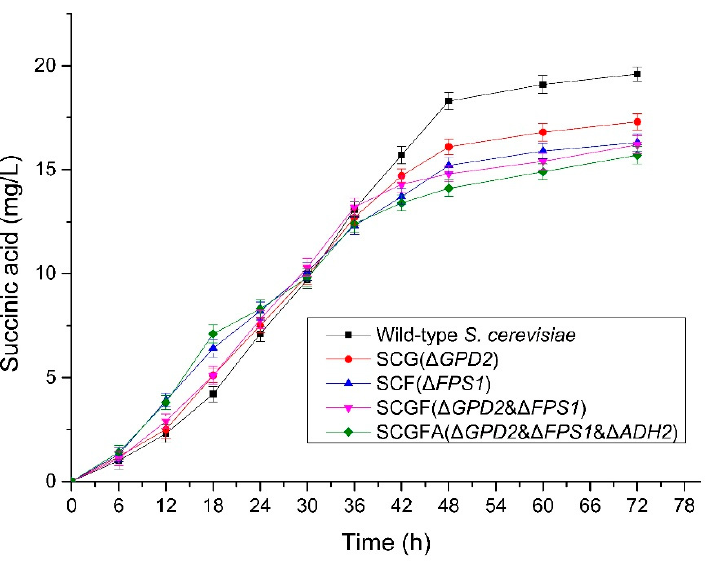
Figure 9. Succinic acid concentrations of the wild-type and engineered S. cerevisiae strains.